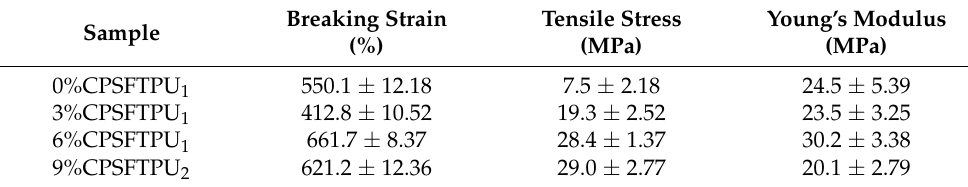
Table 3. Mechanical properties of x%CPSFTPU 1 series with different crosslinker